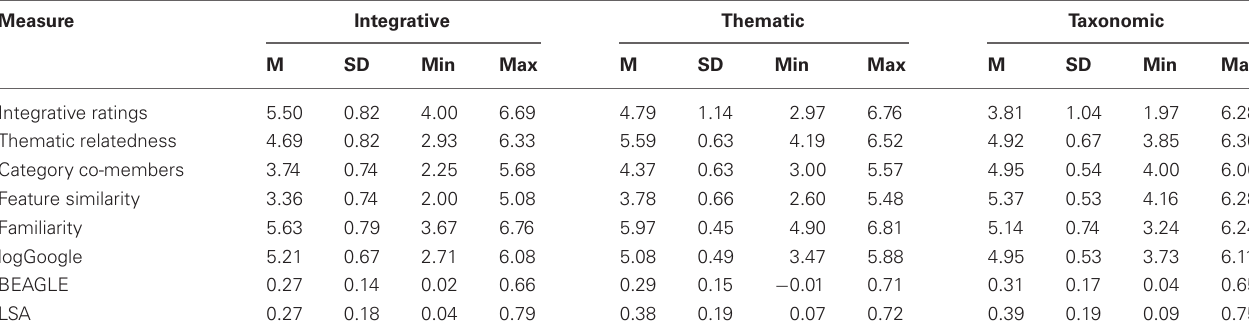
Table 3 | Study 3, Means, Standard Deviations, Minimums, and Maximums of Measures.